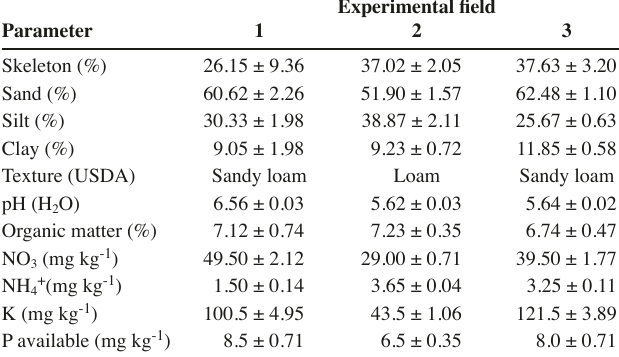
Tab. 2: Physico-chemical properties of soil of each experimental field (data source: CRC Ge.S.Di.Mont., 2019). The identification code of each field is the same as that used in Tab.